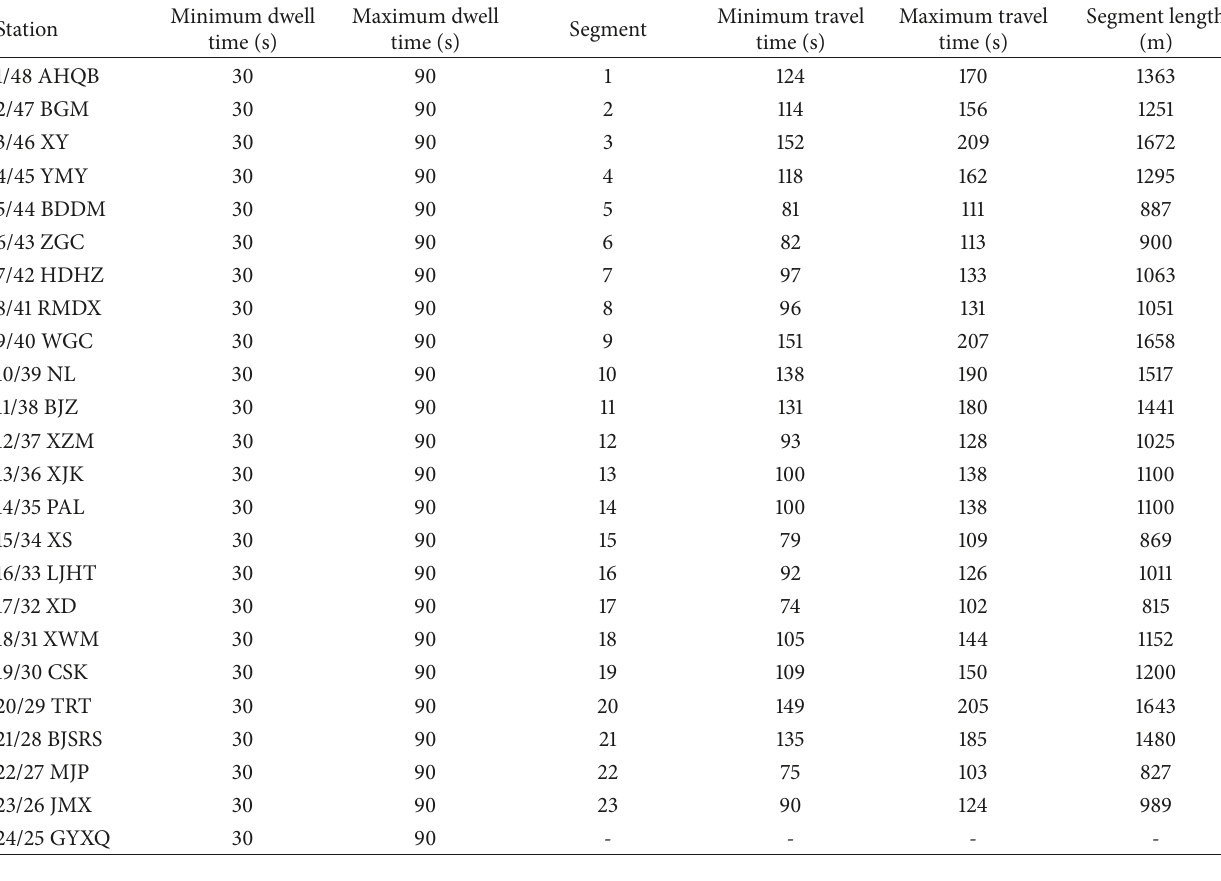
Table 7: Real-world infrastructure data of Beijing Metro Line 4.